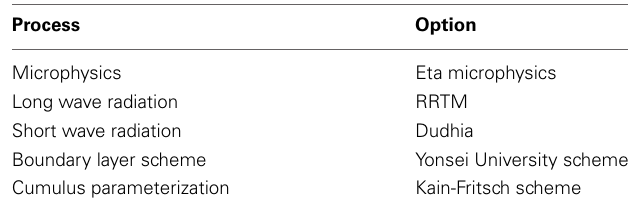
Table 1 | WRF model configuration.